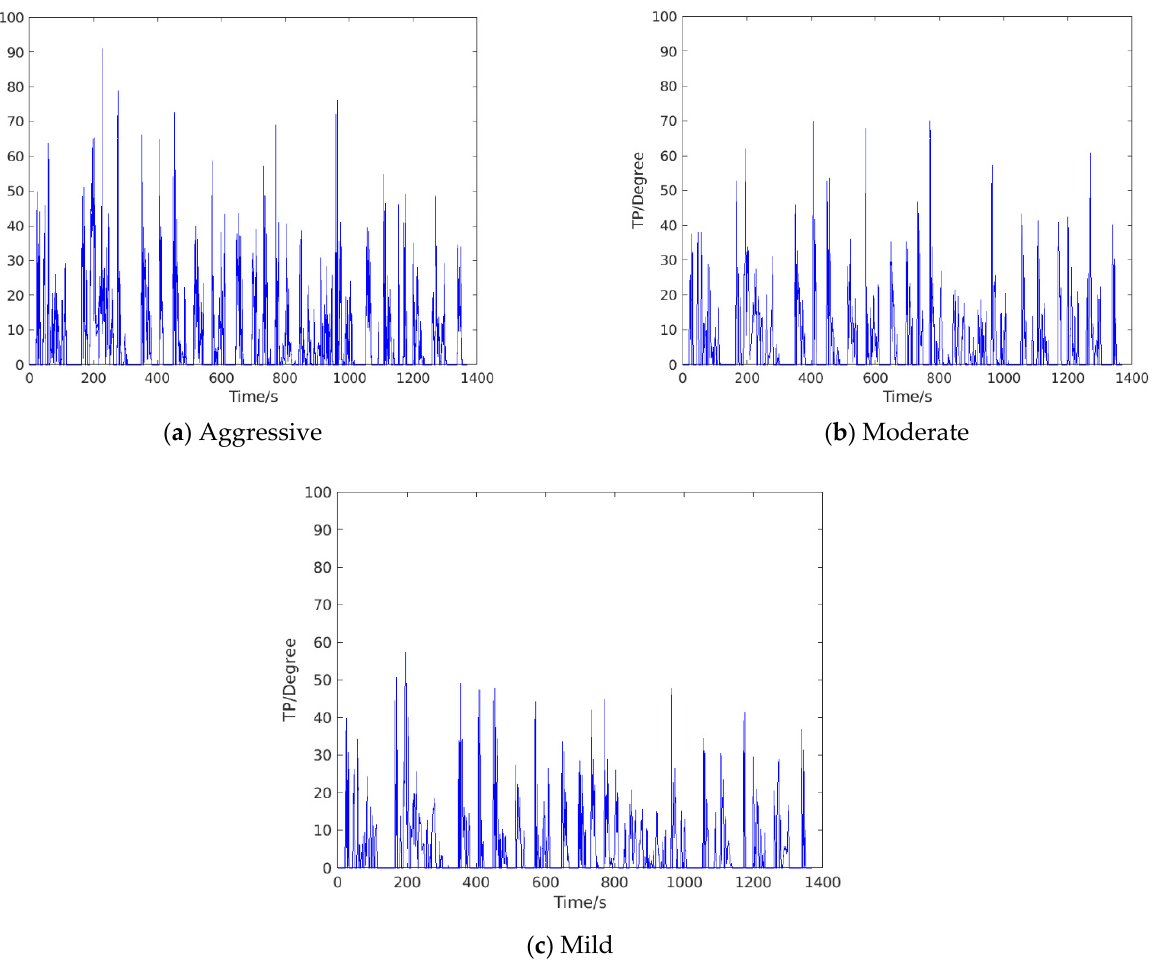
Figure 9. TP of different styles after calibration: ( a ) Aggressive driver; ( b ) Moderate driver; ( c ) Mild driver. Table 4. Calibration statistics among three styled